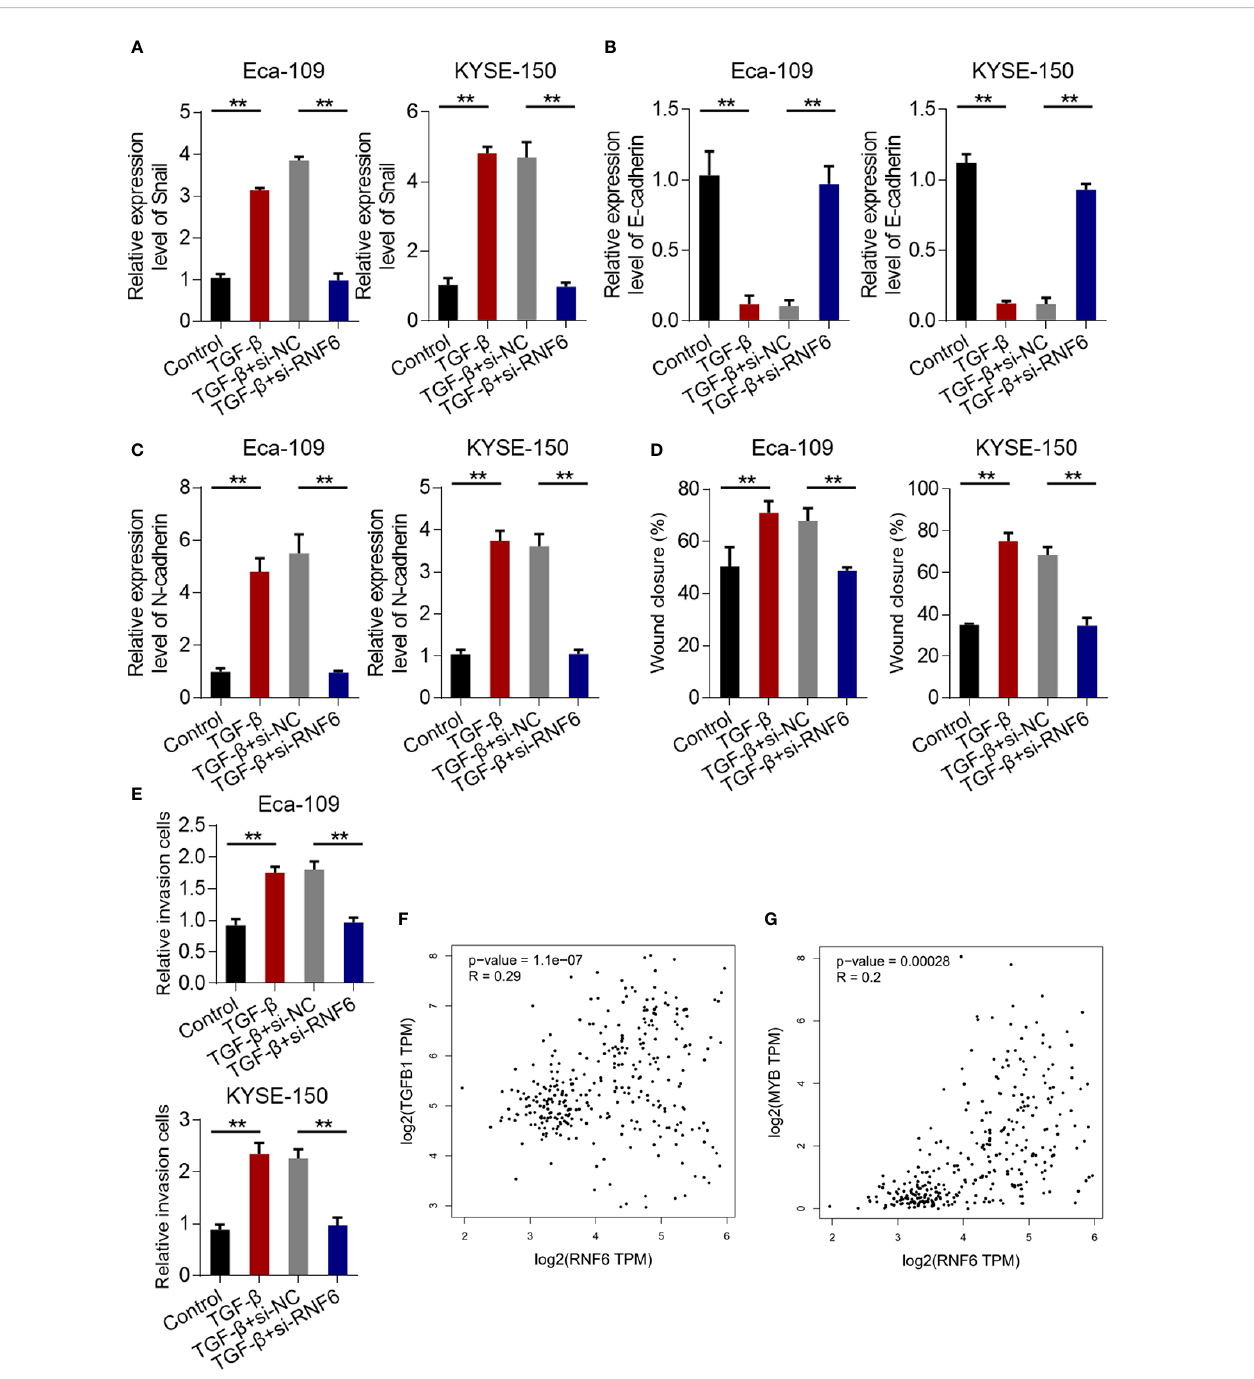
FIGURE 6 RNF6 regulates the migration and invasion of esophageal cancer cells by activating the TGF- b pathway. (A) qPCR analysis of Snail mRNA levels in Eca- 109 and KYSE-150 cells treated with silenced RNF6 or TGF- b 1. (B) qPCR analysis of E-cadherin mRNA levels in Eca-109 and KYSE-150 cells treated with silenced RNF6 or TGF- b 1. (C) qPCR analysis of N-cadherin mRNA levels in Eca-109 and KYSE-150 cells treated with silenced RNF6 or TGF- b 1. (D) Effects of silencing RNF6 or TGF- b 1-treated Eca-109 and KYSE-150 cells on migration. (E) Effects of silencing RNF6 or TGF- b 1 treatment on invasion of Eca-109 and KYSE-150 cells. n=3, **P < 0.01, ANOVA analysis. (F) The co-expression correlation between RNF6 and TGF- b . (G) The co-expression correlation between RNF6 and